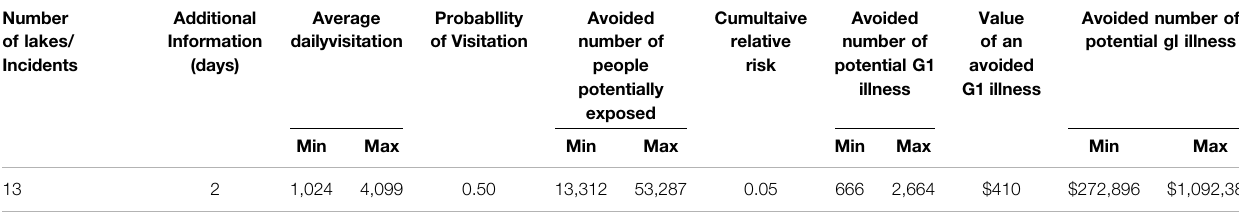
TABLE 2 | Avoided health effects from cyanobacteria harmful algal bloom information. Number of lakes/